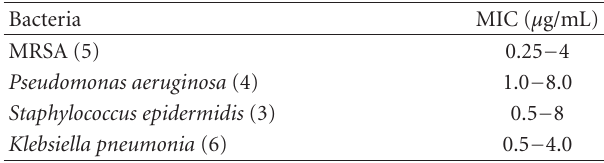
Figure 2: Analysis of the purity of peptide S16 by HPLC Table 3: MIC tests on four strains of clinical Acinetobacter baumannii isolates.